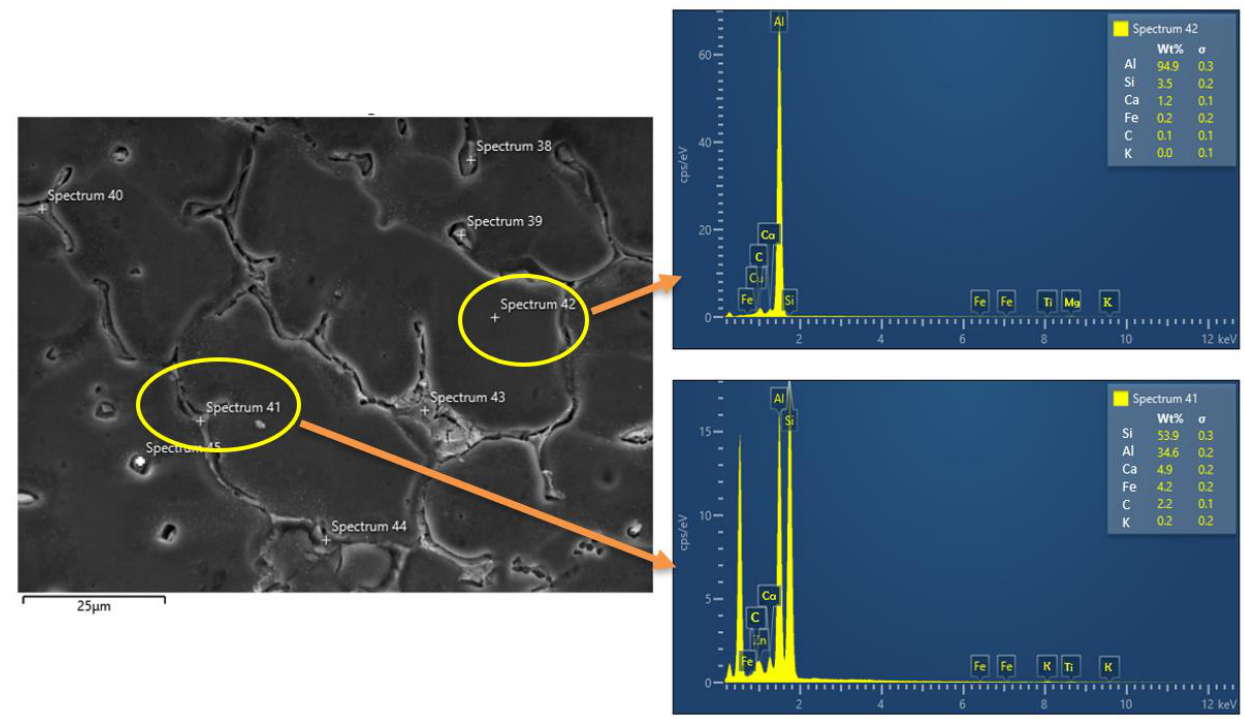
Figure 6. EDS analysis at grain boundary (Spectrum 41) and grain interior (Spectrum 42) of the composite.